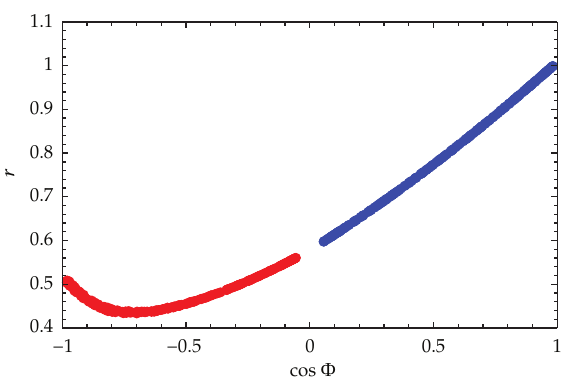
Figure 1: Allowed parameter region by the 1 σ experimental constraints (cid:2) 2.9 (cid:3) for the ratio r (cid:7) C/B as a function of cos φ . The blue (cid:2) dark (cid:3) and red (cid:2) light (cid:3) curves correspond to the IH and NH